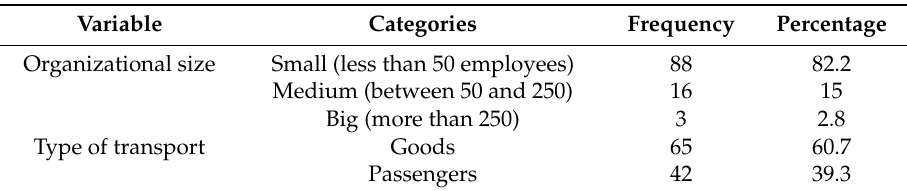
Table 1. Sample characteristics (N = 107